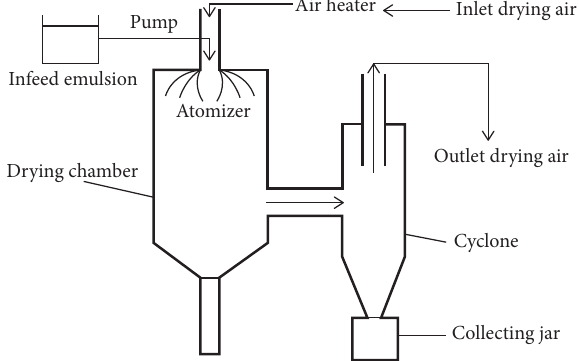
Figure 1: Schematic diagram of the spray